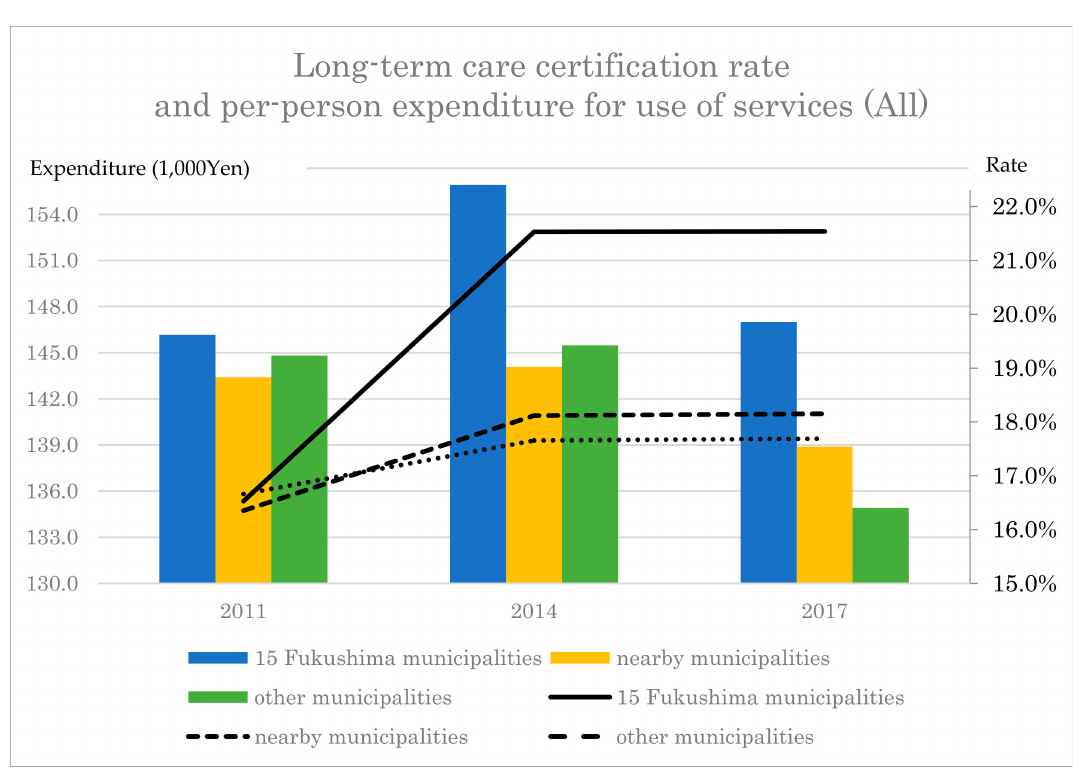
Figure 1. The change of long-term care certification rate and per-person expenditure for use of services for 6